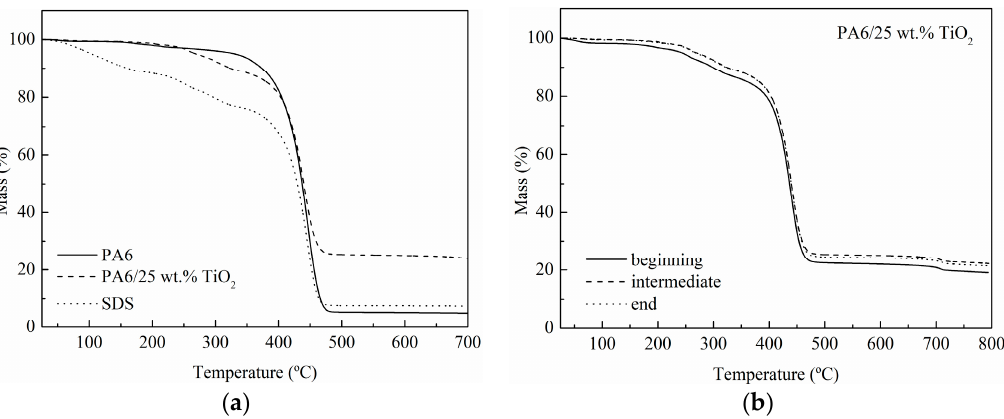
Figure 2. TGA thermograms of: ( a ) membranes made of PA6 electrospun nanofibres and PA6/25 wt.% TiO 2 electrospun nanofibers, and ( b ) three different areas of the PA6/25 wt.% TiO 2 electrospun nanofibres.